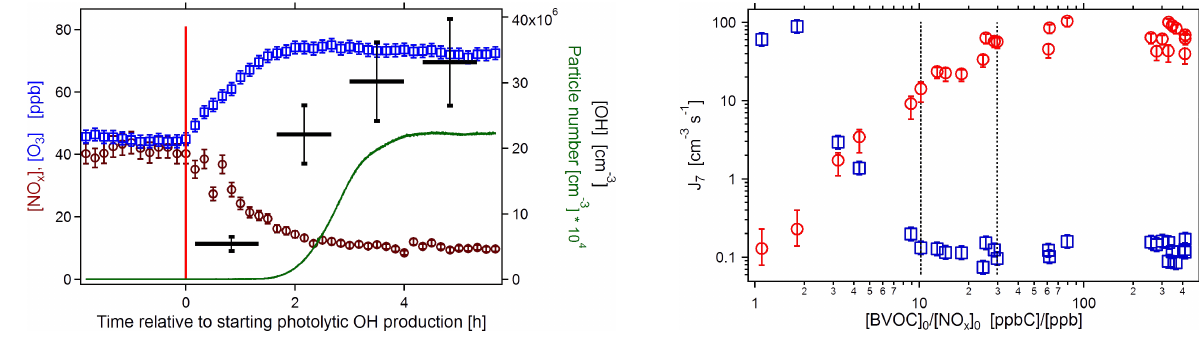
Fig. 5. Rates of new particle formation ( J 7 , red circles, left scale) Fig. 4. Temporal behavior of [NO x ] (brown circles, left scale, ± 8%), [O ± 2ppb), particle number and rates of photochemical ozone formation (P(O 3 ) , blue squares, 3 ] (blue squares, left scale, right scale) in dependence of BNR. The cluster at high BNR stems concentration (green line, right scale, multiplied by 10 4 for clar- from measurements without NO x addition. The dashed lines show ity), and [OH] (black bars, right scale, ± 20%) in an experiment the region 30>BNR>10 where J 7 decreased by an order of mag- with [NO x ] 0 ∼ 40ppb, [BVOC] 0 ∼ 124.5ppbC. OH concentra- nitude but P(O 3 ) stayed low. Note the logarithmic scale for J 7 and tions were measured indirectly by GC-MS with a time resolution the linear scale for P(O 3 ) . Errors in P(O 3 ) were estimated to be of ∼ 70min. The red bar shows the time when the TUV lamp was ± 2.5ppbh − 1 . Errors in J 7 due to wall losses and background par- switched on. ticle numbers were estimated as described in Sect. S7 of the Sup-